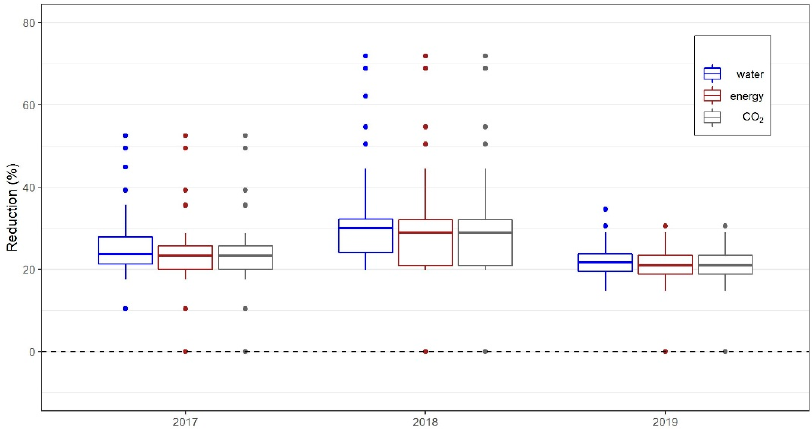
Figure 3. Simulated reduction of irrigation water and energy requirements and CO 2 emissions by reducing the rate of soil reservoir replenishment (FC-WP) from 100 to 85%.